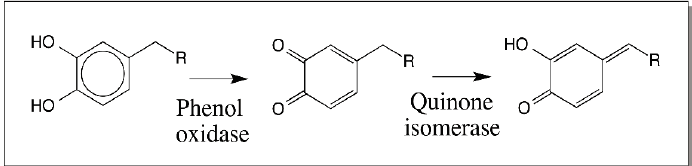
Figure 11. Mechanism of quinone methide production in insect cuticle. Quinone methide production